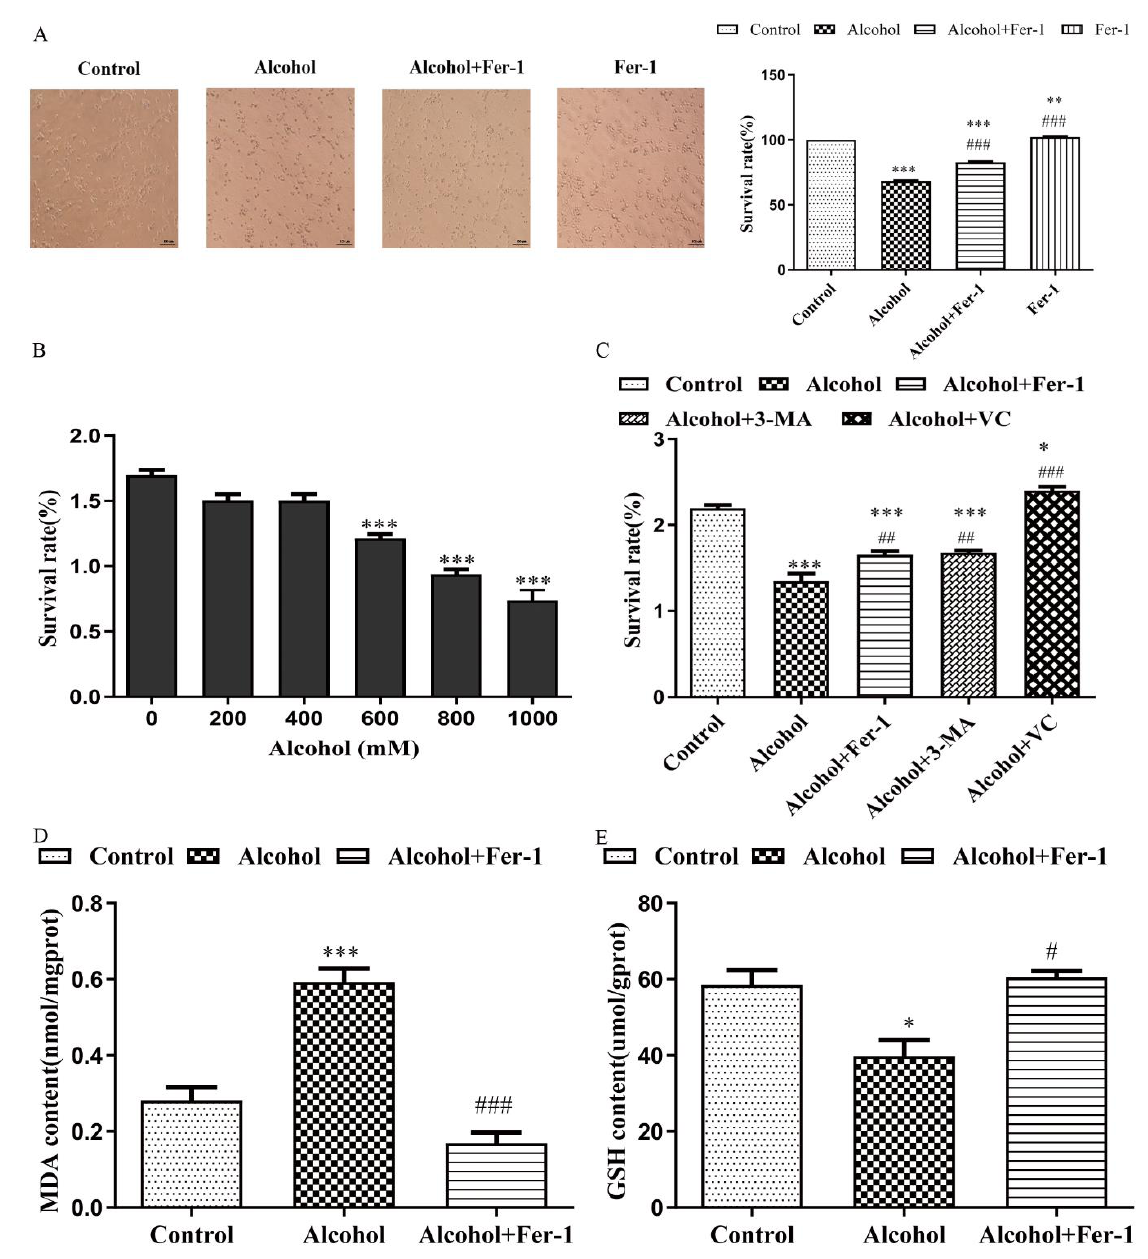
Figure 5. Fer-1 improved alcohol-induced cell death in vitro. ( A ) The effect of alcohol and ferrostatin-1 (Fer-1) on primary cultured neural cells, ( B ) cytotoxicity of alcohol to Neuro 2a (N2A) cells, ( C ) cytotoxicity of different inhibitors to N2A cells, Fer-1 (10 μM), 3-methyladenine (3-MA) (1 mM), vitamin C (VitC) (200 μM), ( D ) the level of lipid peroxides malondialdehyde (MDA) in N2A cells, ( E ) the level of L-glutathione (GSH) in N2A cells. Data are presented as the mean ± SEM. Statistical analysis was carried out by one-way ANOVA for multiple comparisons with Tukey post hoc test, * p < 0.05, ** p < 0.01, *** p < 0.001 vs. control group; # p < 0.05, ## p < 0.01, ### p < 0.001 vs. alcohol group.